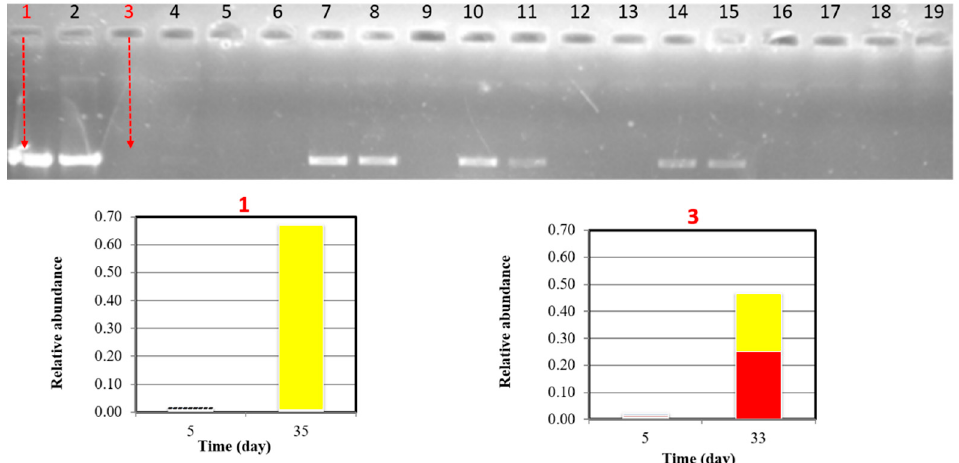
Figure 2. PCR products obtained with the specific 16S- Desulfuromonadaceae primers. Samples 1–19 were tested as representative samples for the presence and absence of Desulfuromonadaceae and Geabacteraceae bacterial families, as indicated in Table 2. The anodic composition of Samples 1 and 3 are shown as an example illustrating the association of community composition to a positive and negative PCR product of this primer set, respectively. The samples used for testing the di ff erent primer sets for their specificity to the Desulfuromonadaceae and Geabacteraceae groups with their relative abundance according to amplicon sequencing